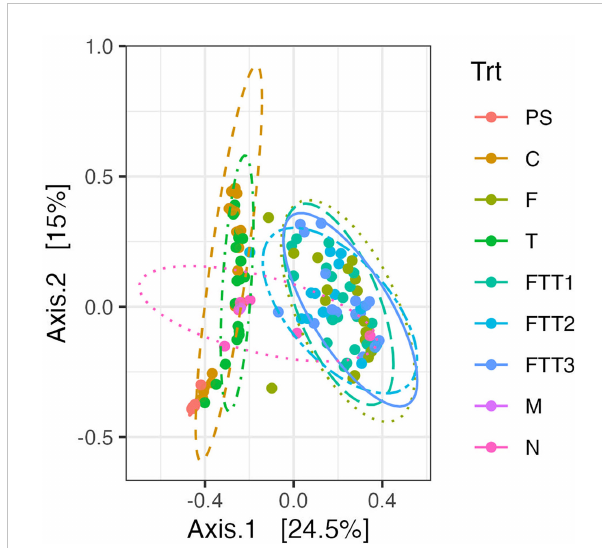
FIGURE 3 A principal coordinate analysis (PCoA) using the Bray-Curtis dissimilarity index was constructed for the six soil treatments; control (C), Fusarium (F), Trichoderma (T), Fusarium Trichoderma Time 1 (FTT1), Fusarium Trichoderma Time 2 (FTT2), and Fusarium Trichoderma Time 3 (FTT3). The pre-steamed soil (PS), the mock community (M), and the negative controls (N), are included in the plot. 95% con fi dence interval ellipses were drawn. There were two distinct groupings. The fi rst: C and T the second: F, FTT1, FTT2, and FTT3.